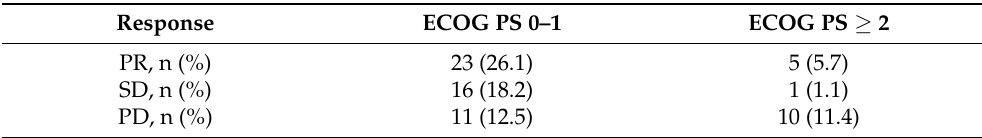
Table 4. Treatment outcomes according to ECOG